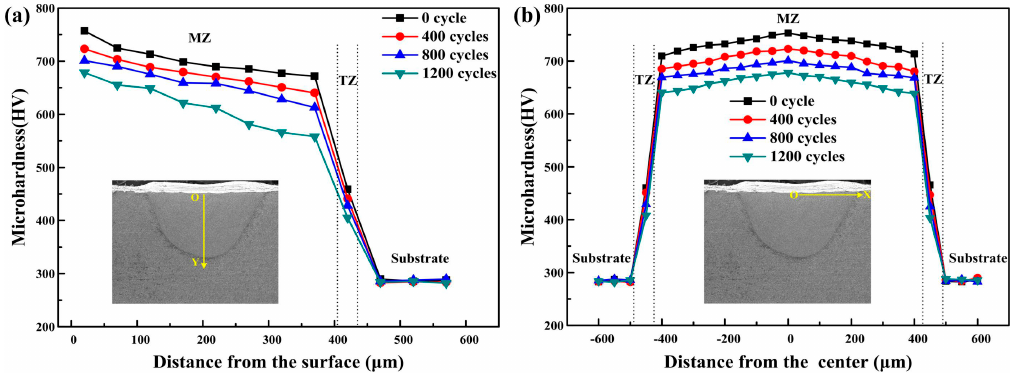
Figure 5. Microhardness profile along the transverse sectional of the LSM-treated specimen after different numbers of thermal fatigue cycles: ( a ) the vertical direction and ( b ) the horizontal direction.